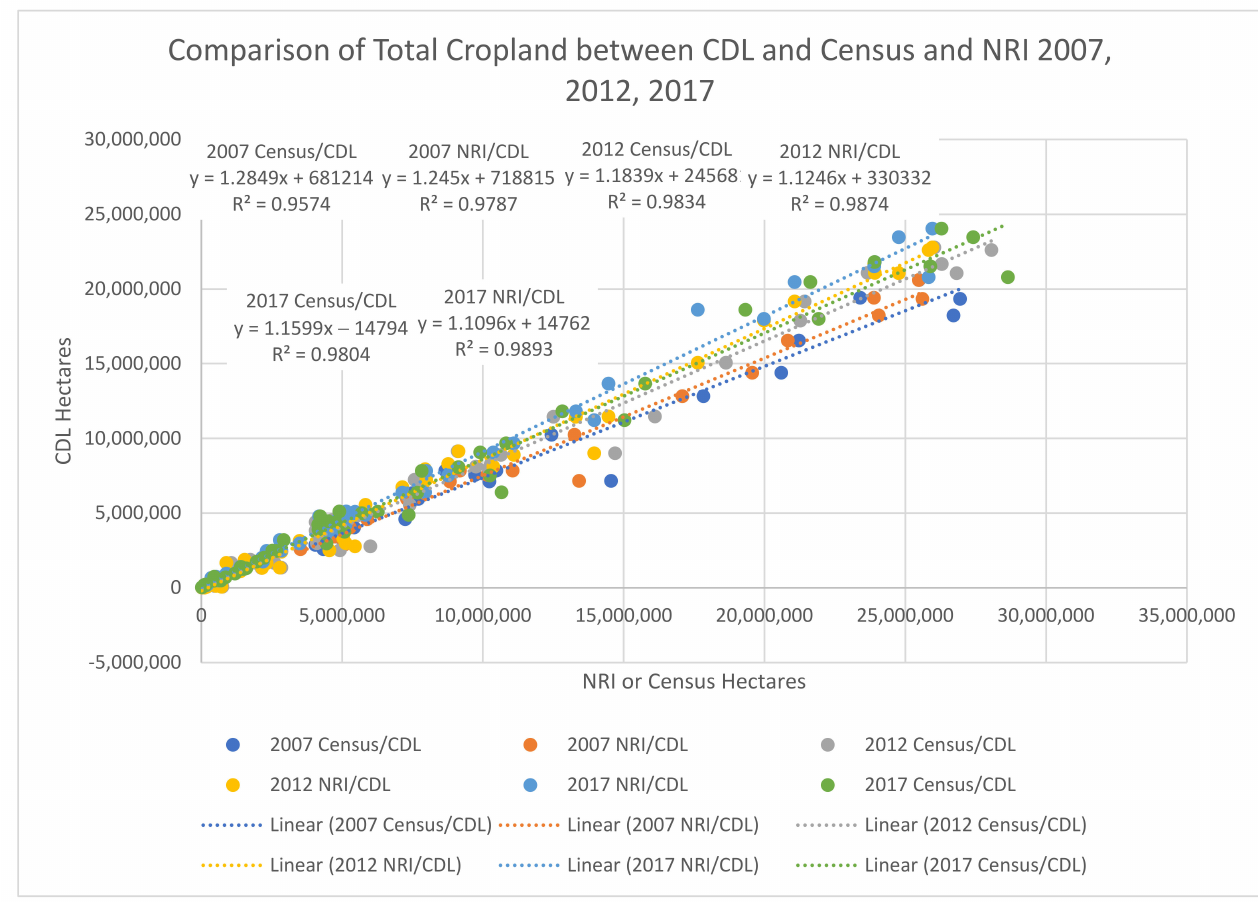
Figure 2. The relationships in total cropland area at the state level estimated using the 2007, 2012 and 2017 CDL with the area estimated from the NRI and Census for corresponding